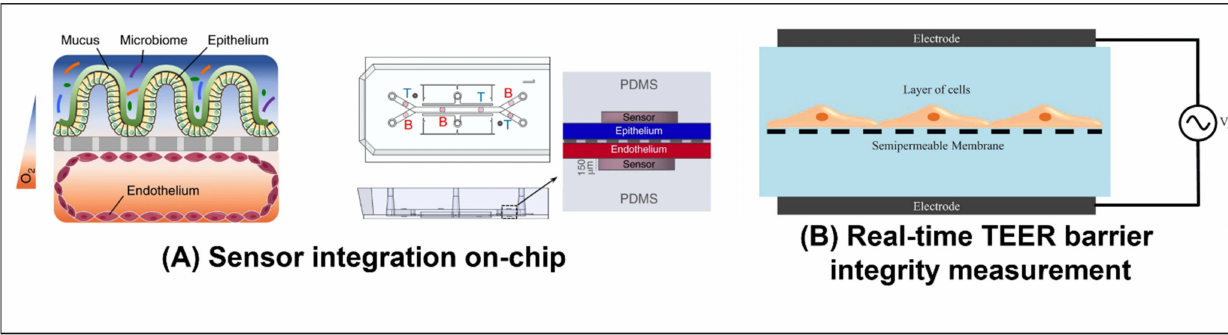
Figure 5. Sensing on-chip: ( A ) Human Caco2 intestinal epithelial cells were grown in the upper section of the channel and human intestinal microvascular endothelial cells (HIMECs) in the lower section. They each then formed a confluent layer. Gut microbia were then introduced in the gut-side of the chip. Before seeding the cells, oxygen-sensitive and optical isolating particles were mixed to make optical oxygen sensor spots on the chip. The oxygen levels could then be monitored non-invasively, throughout the culture period, using a color camera. An oxygen gradient was thus maintained across the intestinal barrier. The hypoxic culture conditions on the gut side of the chip helped maintain an ideal environment for the bacteria. [21]. Reproduced with permission from Nature Biomedical Engineering; published by Springer Nature, 2019. ( B ) The electrical resistance across a physiological barrier can be an indication of how intact the barrier is. To measure this resistance, an electrode is placed on either side of the barrier. A low amplitude AC electric signal is then applied, and a sweep across a frequency range is performed. By measuring the amplitude and phase of the resulting electrical current, one can determine the resistance of the barrier. This process is call impedance spectroscopy [64]. Reproduced with permission from Journal of Laboratory Automation; published by Elsevier,